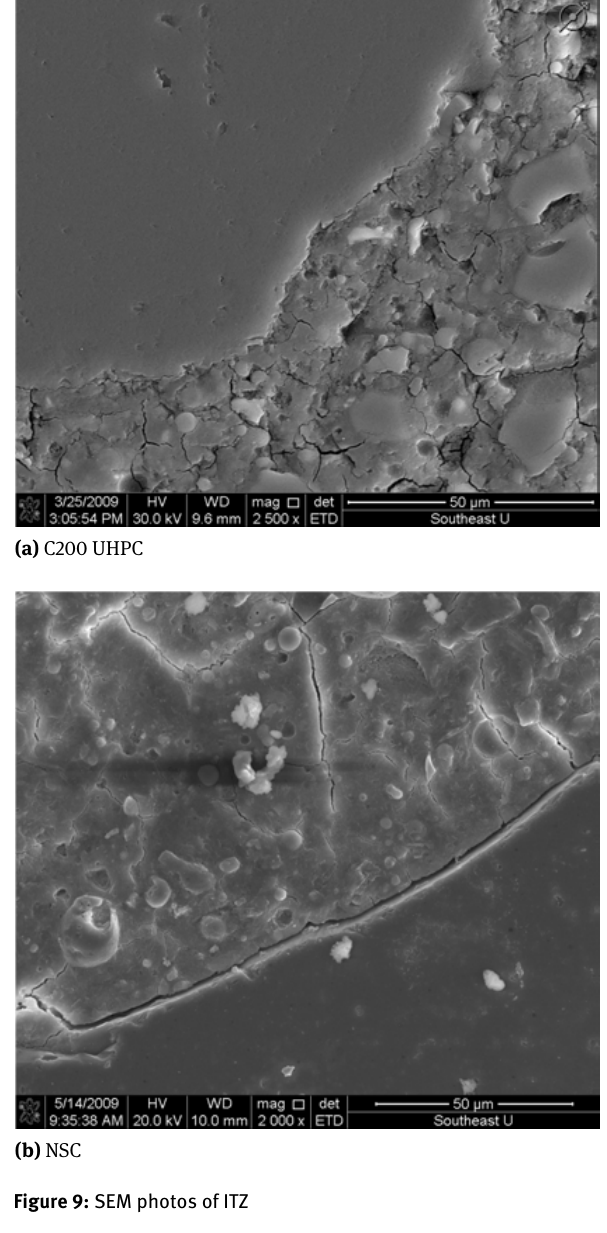
Figure 9: SEM photos of